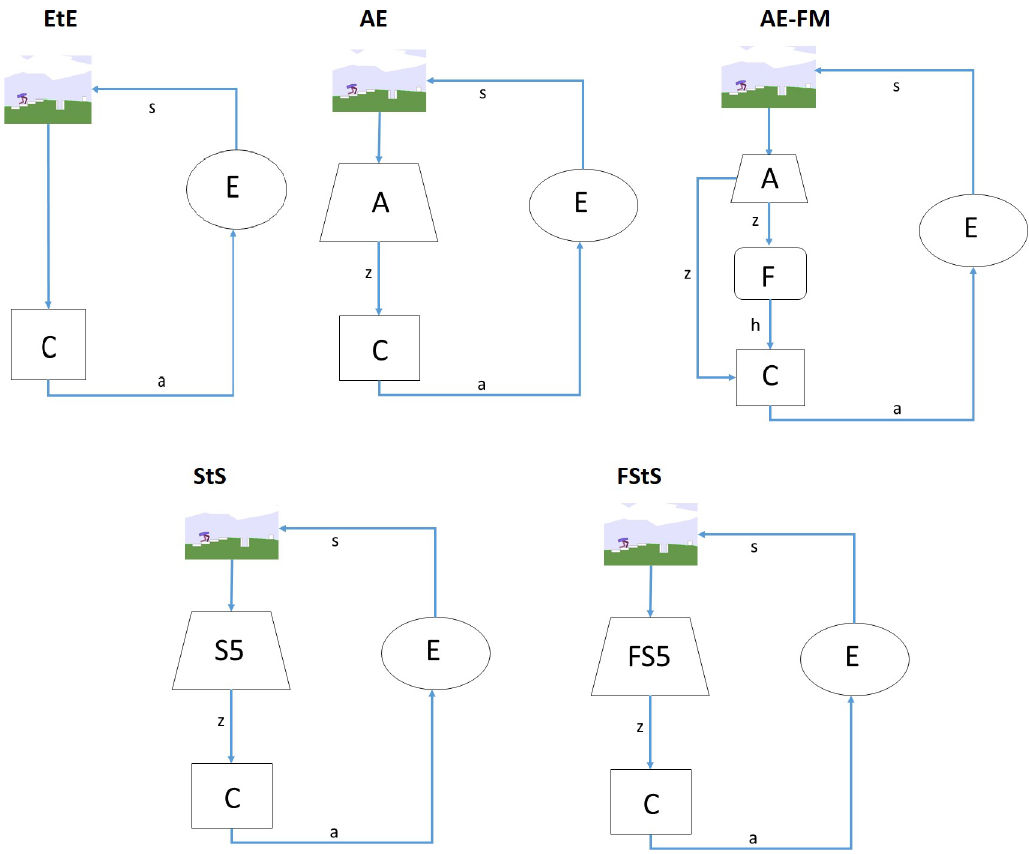
Fig 2. Schematization of the 5 experimental conditions (EtE, AE, AE-FM, StS, and FStS). The picture at the top of each image indicate the observation (e.g. the angle and velocity of the agent’s joint, the proximity measures ext.). The action vectors are indicated with the letter a . The vector of features extracted from the auto-associative or by the sequence-to-sequence network are indicated with the letter z . The vector of features extracted by the forward model is indicated with the letter h . A indicates an auto-associative network that receives as input the observation at time t and produce as output the same observation at time t . F indicates a forward model network that receives as input the vector z , extracted from the auto-associative network at time t , and the action vector a at time t and produces as output the vector z at time t +1 . S5 indicates a sequence-to-sequence associative network that receives as input the observations at time [ t , t ] and produces as output the observation at time [ t , t ]. FS5 indicates -4 -4 a sequence-to-sequence network that receives as input the observation at time [t -4 , t] and produces as output the observations at time [ t -3 , t +1 ]. C indicates the control network that receives as input the observation (in the case of the EtE condition), or the features vector z (in the case of the AE, StS, and FStS conditions), or the features vectors z and h (in the case of the AE-FM condition). C produces as output the action vector that determines the movement of the agent’s joints or wheels and . The new state of the environment determines the observation at consequently the state (s) of the environment (E) at time t +1 time t +1